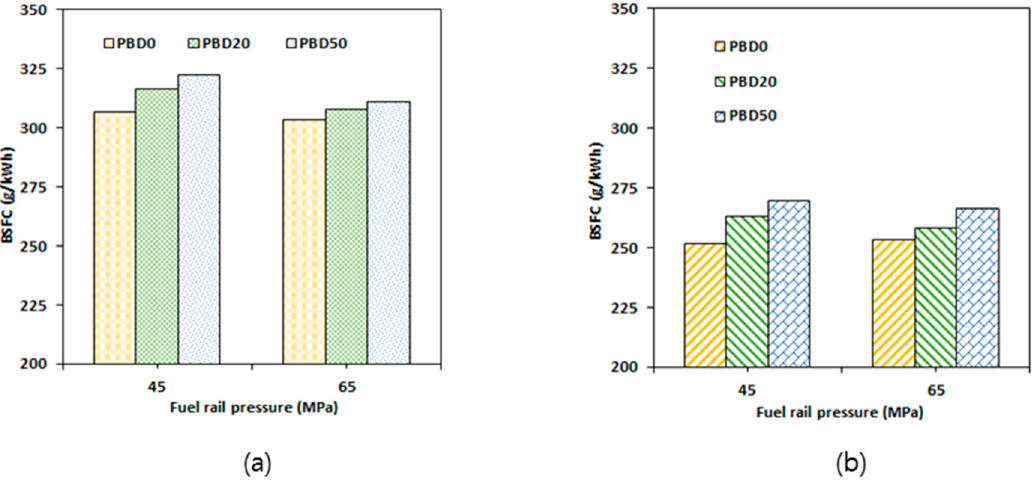
Figure 6. BSFC for engine loads of ( a ) 50 Nm ( b ) 100 Nm. 266